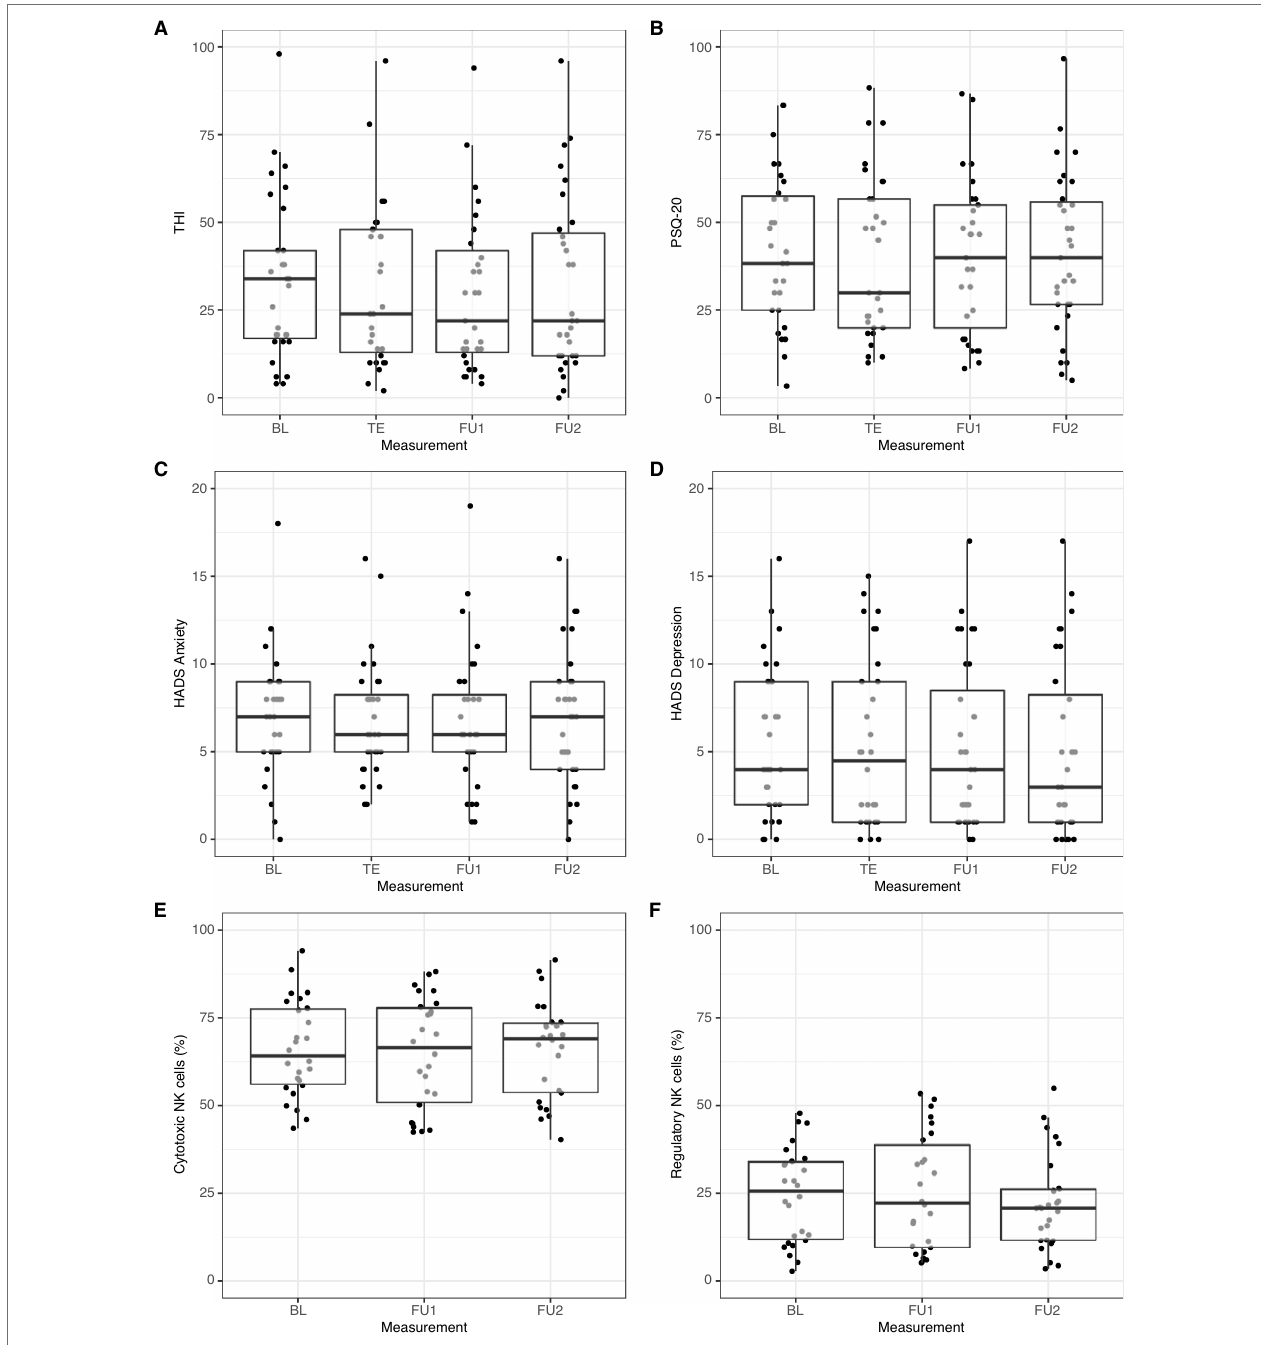
FIGURE 5 | Change in (A) THI, (B) PSQ-20, (C) HADS anxiety, (D) HADS depression, (E) cytotoxic natural killer cell (NKc), and (F) regulatory natural killer cell (NKreg) frequency across measurement sessions. Only participants with complete data from all repeated measurement sessions were included: (A) THI and (B) PSQ-20: n = 31; (C) HADS anxiety and (D) HADS depression: n = 32; (E) NKc and (F) NKreg: n = 26. BL, Baseline; FU1, Follow-up 1 (7.8 weeks); FU2, Follow- up 2 (13.8 weeks); HADS, Hospital Anxiety and Depression Scale; PSQ-20, Perceived Stress Questionnaire (20-item version); TE, Treatment end; THI, Tinnitus Handicap